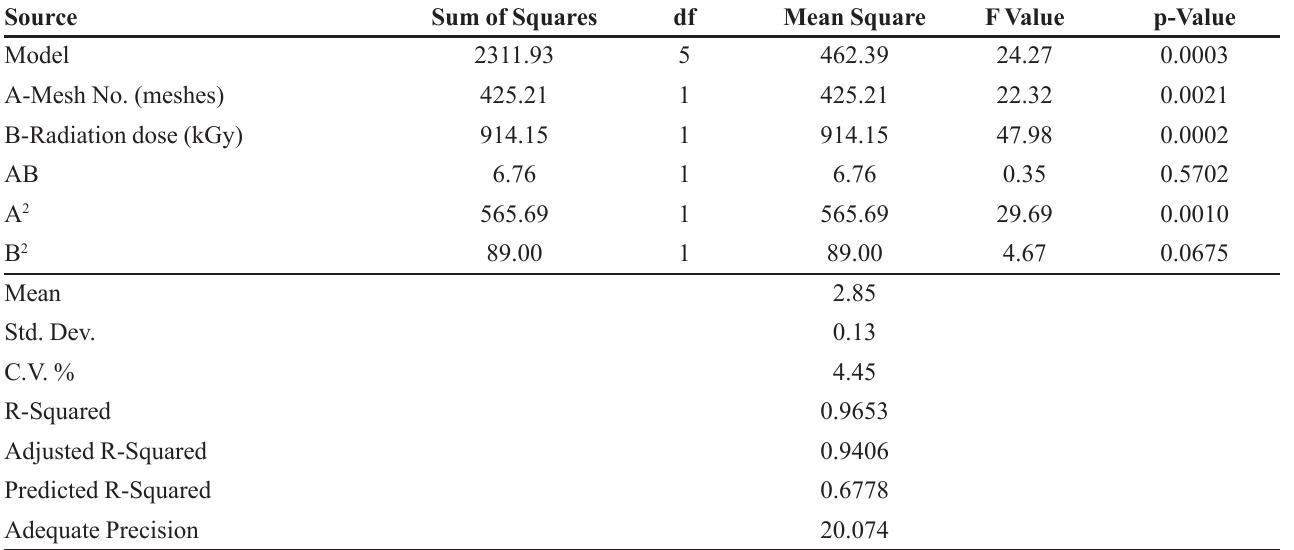
TABLE IIA - Analysis of variance (ANOVA) from the final reduced models for Trolox equivalent total antioxidant activity of gamma irradiated maize flour